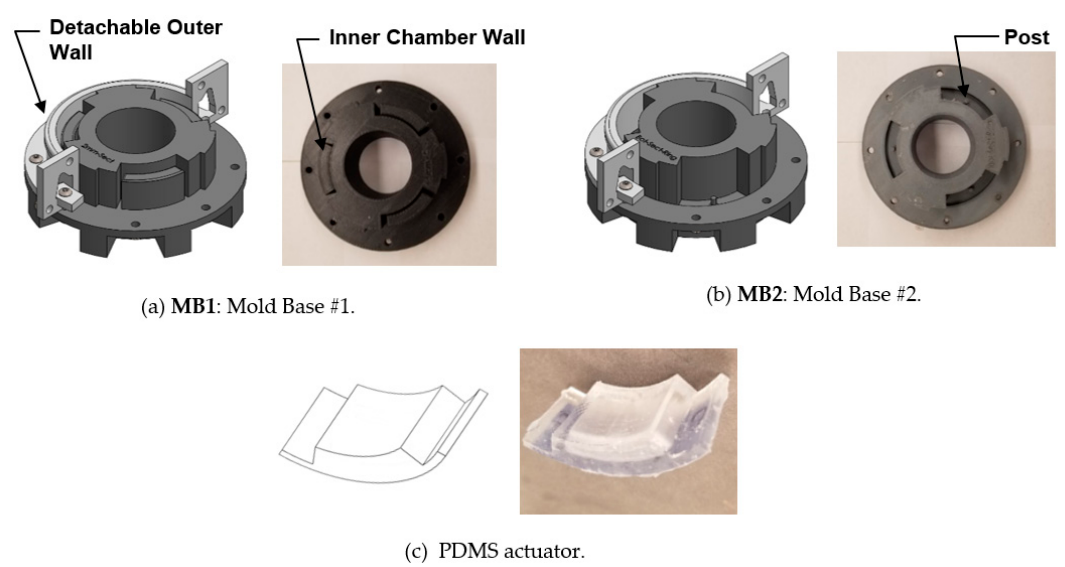
Figure 6. Three-dimensional CAD models and photographs of ( a ) MB1 : mold base 1; ( b ) MB2 : mold base #2; and ( c ) single molded polydimethylsiloxane (PDMS) actuator.